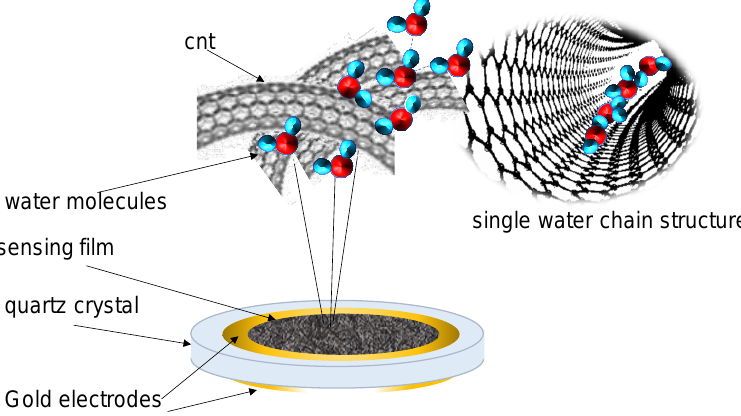
Figure 1. Schematic representation of a CNT-coated QCM humidity sensor.